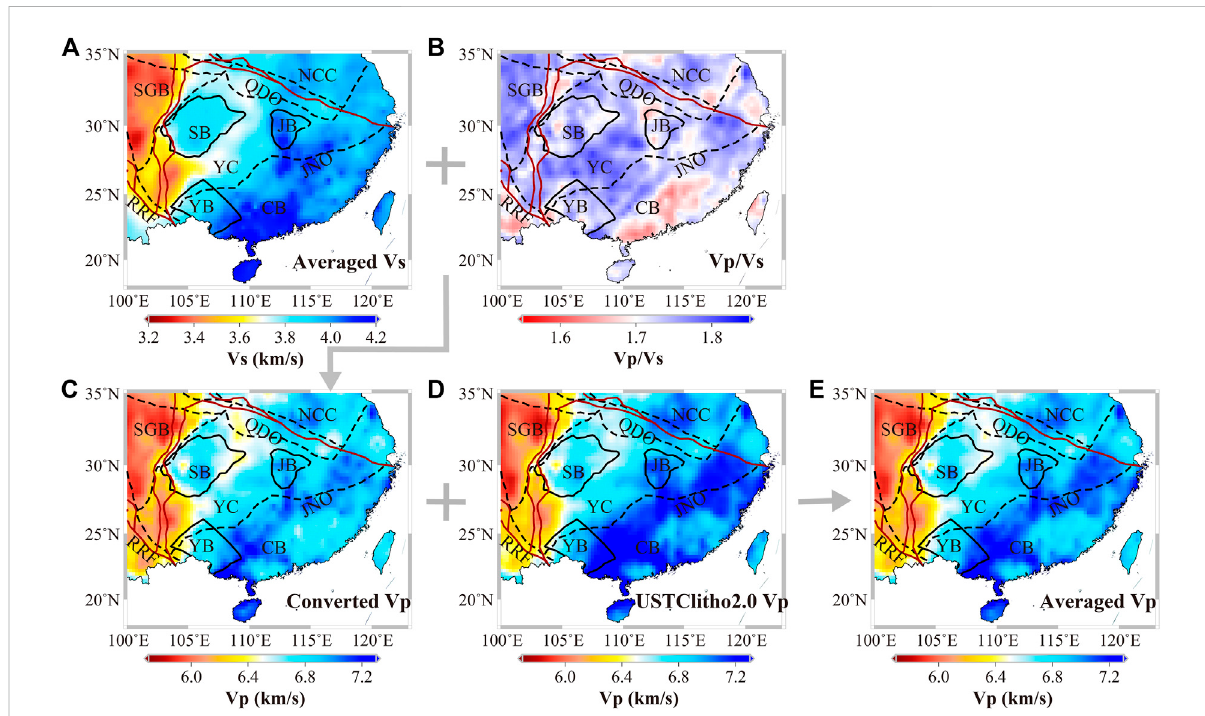
The construction process of P-wave velocity for the crustal and uppermost mantle component of SREM-SC keyed at a map view of 30 km depth. (C) The converted P-wave velocity model is obtained by combing (A) the averaged S-wave velocity model with (B) the Vp/Vs ratio obtained from the USTClitho2.0, and then averaged with (D) The P-wave velocity from USTClitho2.0 (Han et al., 2021) to build (E) the fi nal averaged P-wave velocity for the crustal and uppermost mantle component of